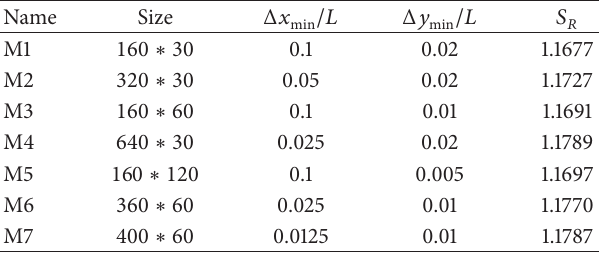
Table 1: Mesh parameters for convergence validation with Wi =